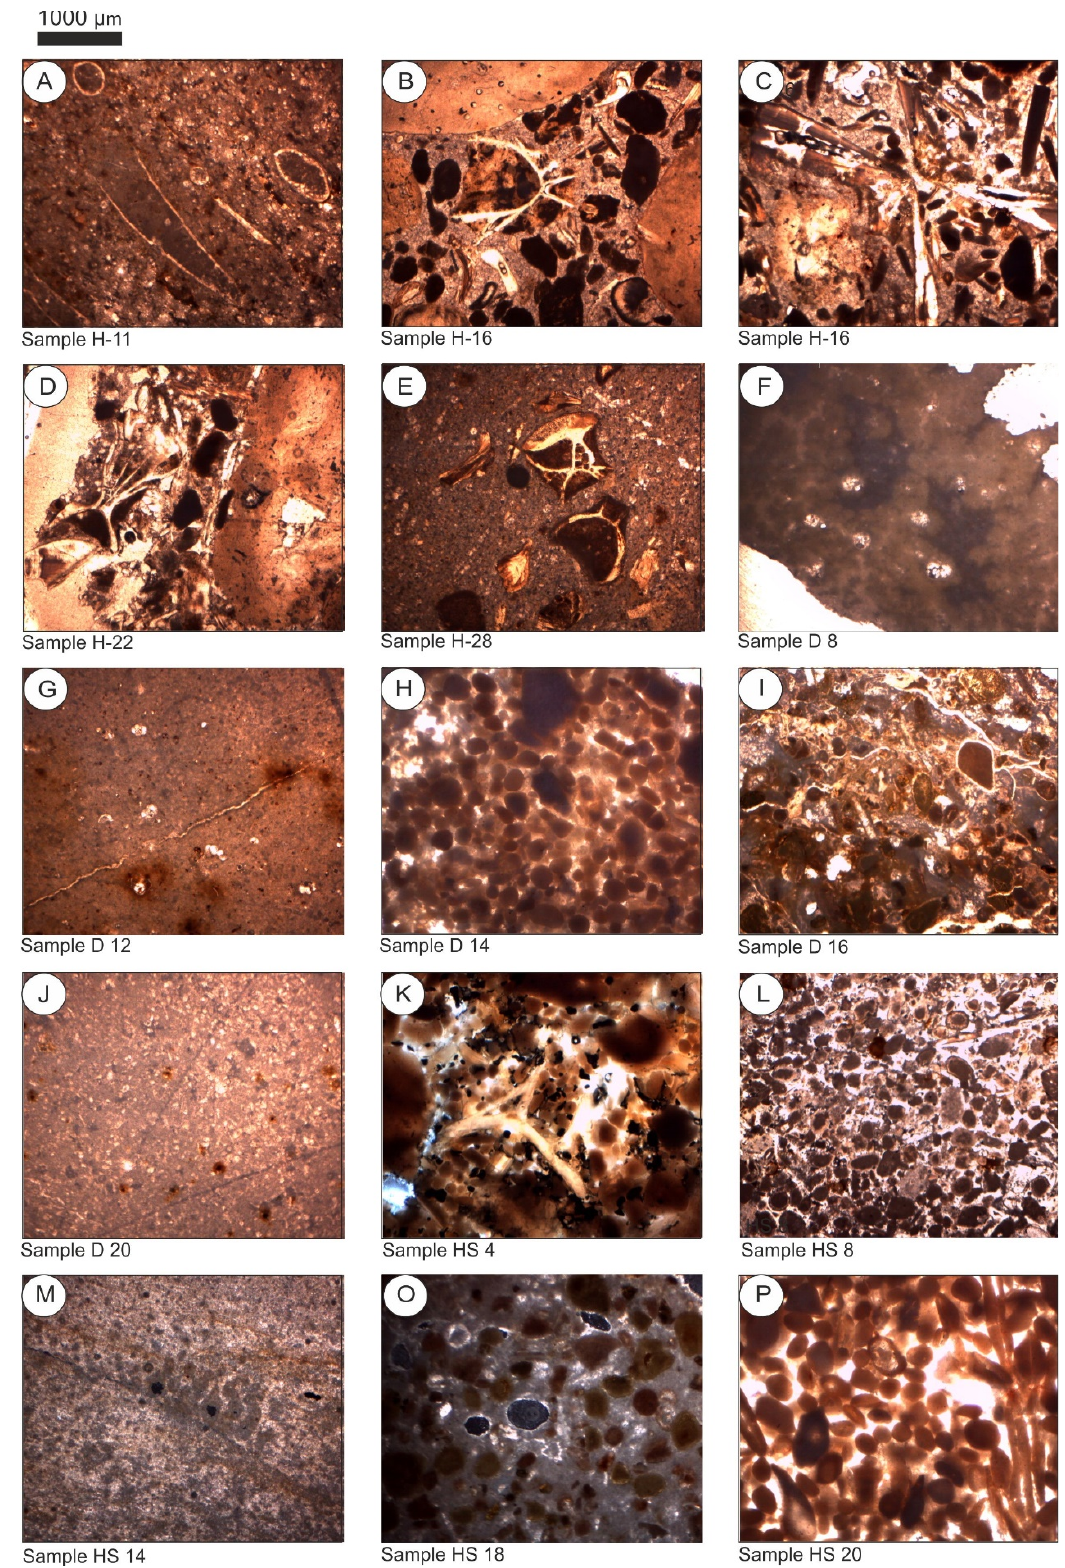
Figure 5. Microphotographs represent the textural contents of sections 1, 2, and 3. Microphotographs ( A , F , G , J , M ) show the wackstone facies. ( B – E , K ) represent the skeletal frames within the grainstone, while ( H , I , L , O , P ) show the pelletal components within the grainstone